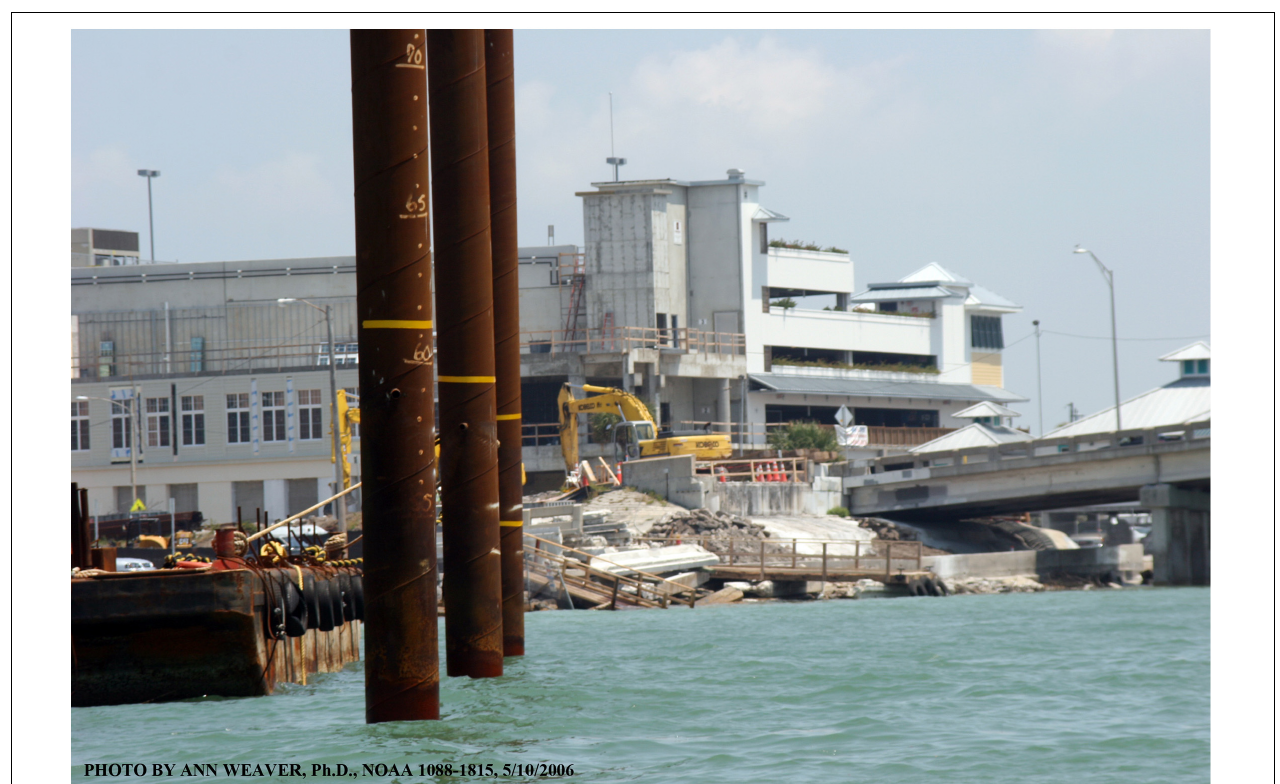
FIGURE 8 | The third set of impacts was mainly related to below + above water activity to rebuild the new bridge. Shown here is the NW portion of the construction of new W lanes and cement debris being broken into smaller-sized rubble for transport.